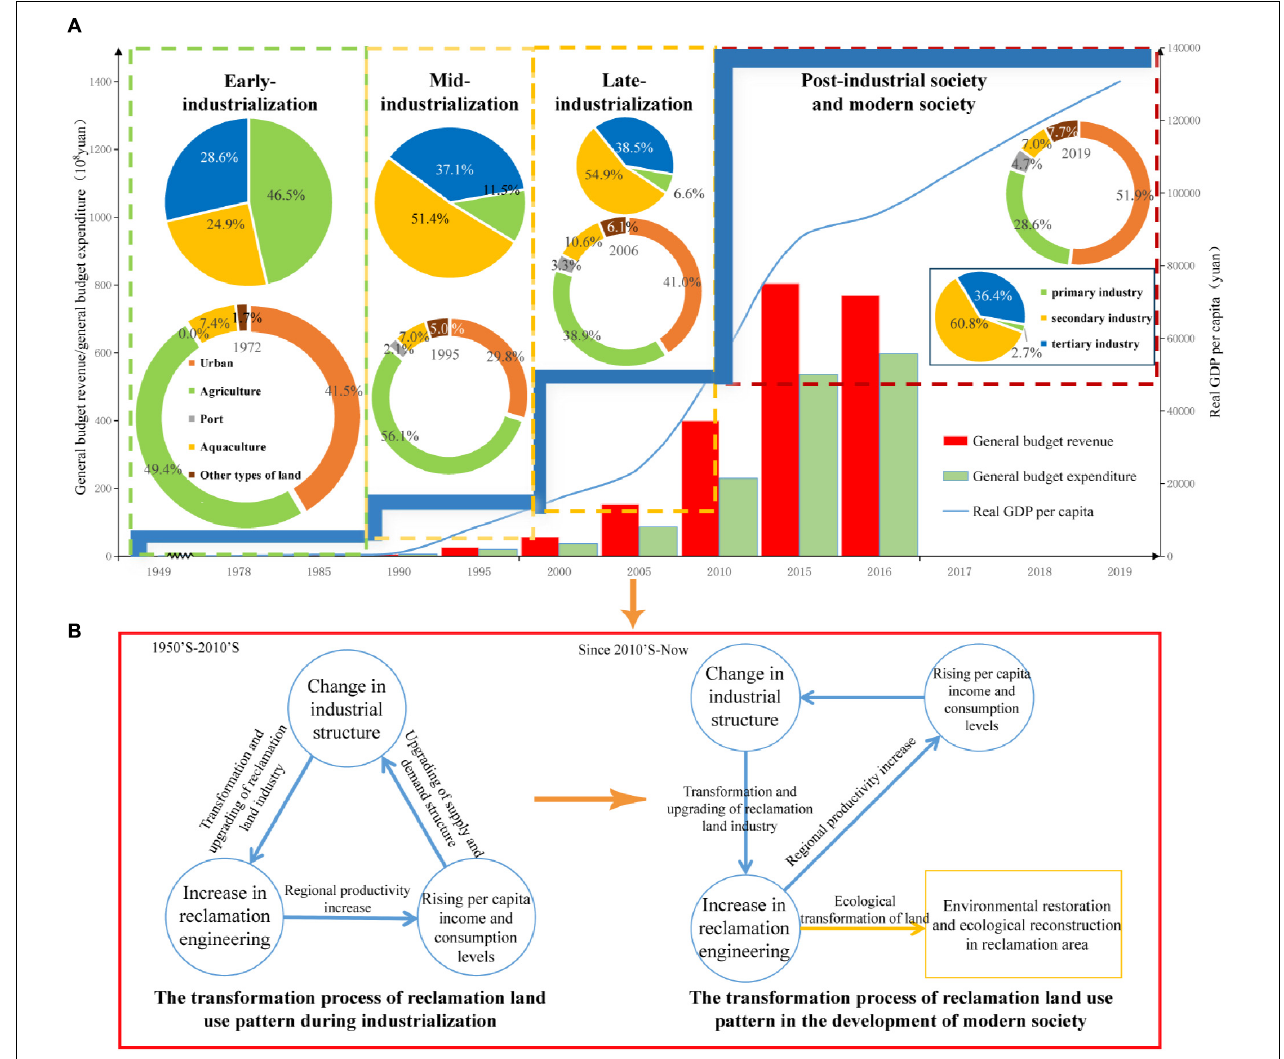
FIGURE 6 | (A) The stages division of land reclamation with economic structure in Quanzhou Bay. The pie chart shows the proportion of different industries; the circular chart shows the proportion of different land uses; GDP, population, General budget revenue, and General budget expenditure data from http://tjj.quanzhou.gov.cn/tjzl/tjsj/. (B) Conversion model of reclaimed land in Quanzhou